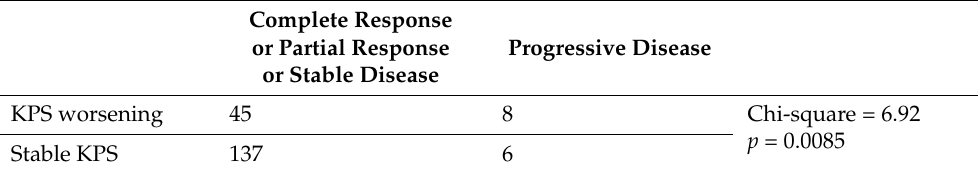
Table 6. The correlation between deterioration of KPS and disease control rate 6 weeks after the end of